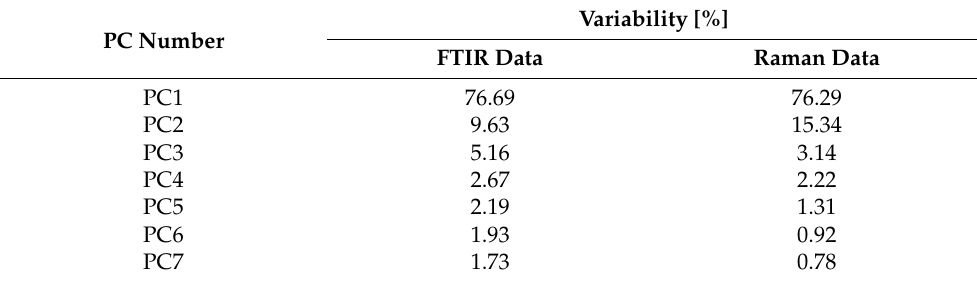
Table 2. Variability explained by the principal components (PCs) obtained by decomposition of the spectral data (red grape skin extracts) using principal component analysis (PCA).